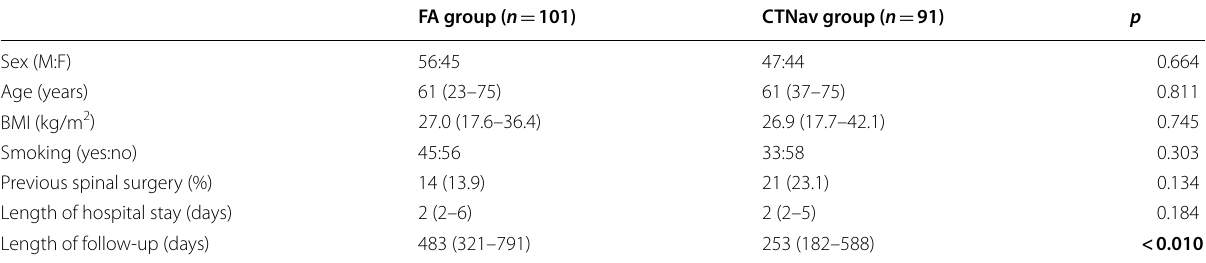
101) and CTNav ( n 91) technique = =